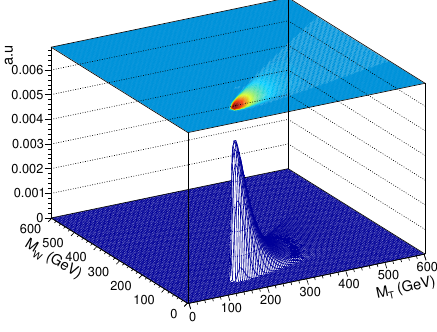
Figure 3 . Average PDF weighted solvability for the 100 smeared events produced from the same initial top pair event. The distribution is normalized to unit